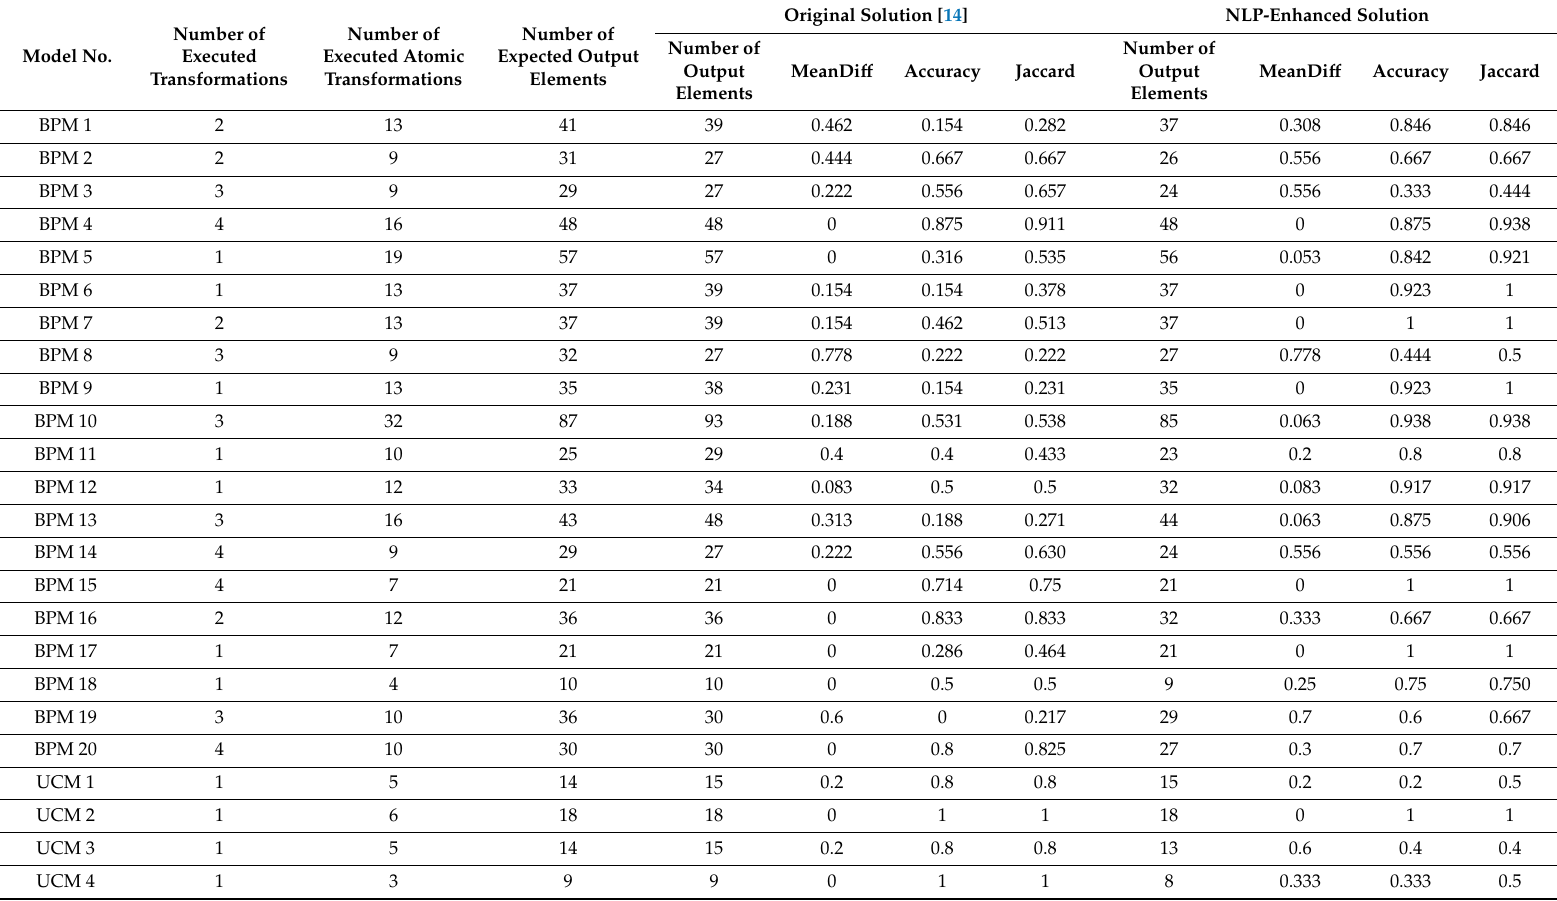
Table 2. Experiment results for partial M2M transformation